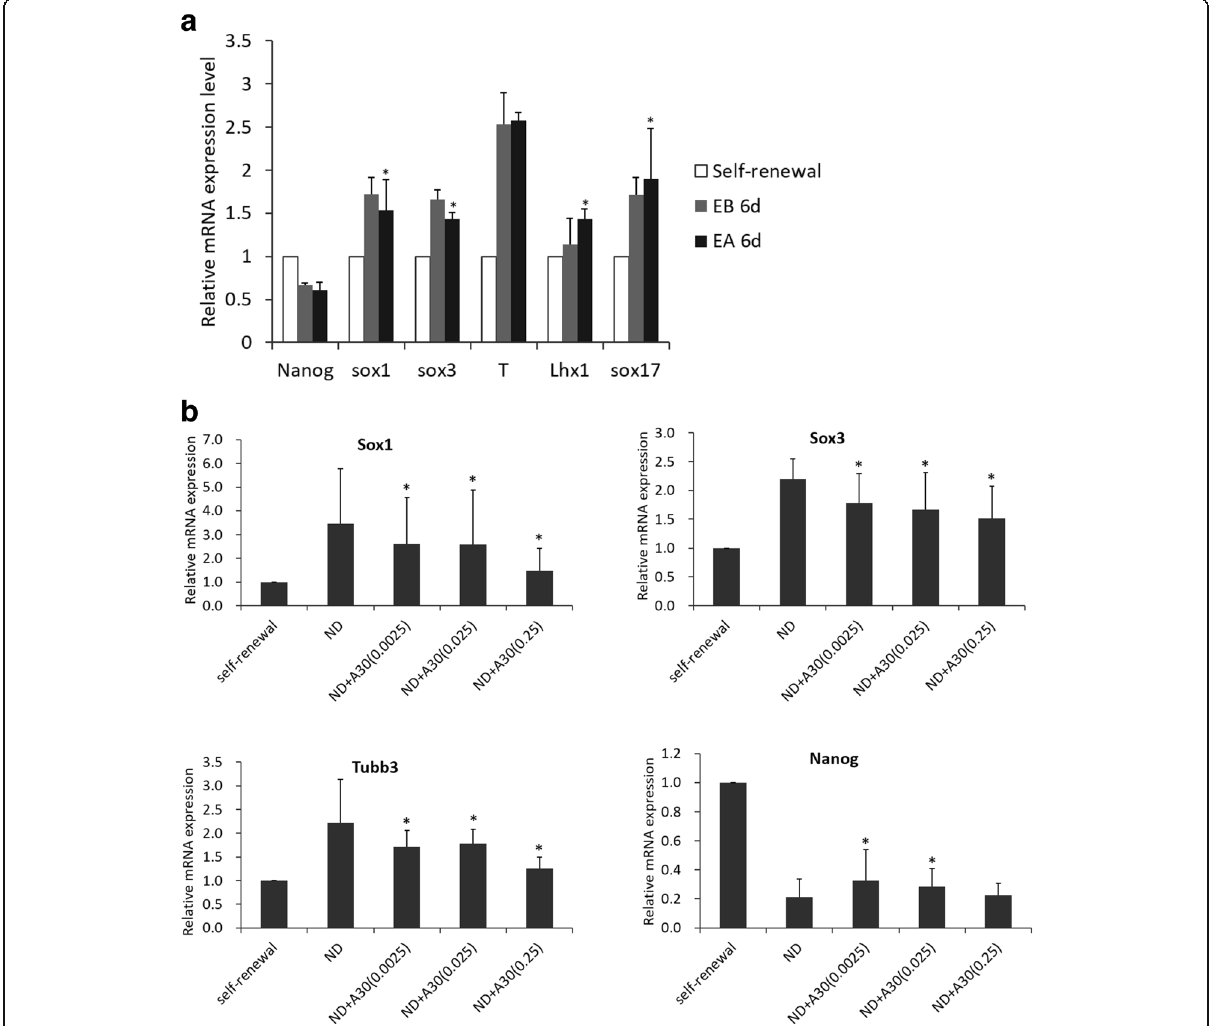
Fig. 8 Effect of A30 on differentiation of embryonic stem cells into different germ layer lineages. Nanog, stemness marker; Sox1, Sox3 and Tubb3, ectodermal differentiation markers; Lhx1, mesodermal differentiation marker; Sox17, endodermal differentiation marker; T, mesendodermal differentiation marker. a mRNA expression analysis of ectodermal, mesodermal and endodermal differentiation markers in MESC-R1 derived embryoid body (EB) upon the A30 treatment for 6 days after EB formation. Self-renewal, undifferentiated MESC-R1 cells; EB, embryoid body- differentiated MESC-R1 cells; EA, embryoid body differentiated MESC-R1 cells treated with 0.25 μ g/ml of A30. b mRNA expression analysis of ectodermal differentiation markers in neuroectodermal differentiated MESC-R1 cells upon the A30 treatment at different concentrations for 5 days. Self-renewal, undifferentiated MESC-R1; ND, neuroectodermal differentiated MESC-R1. A30 concentration umit is μ g/ml. The symbol * represents p < 0.01 compared with EB group ( a ) or ND group ( b ) by ANOVA with Tukey ’ s test post-hoc for the corresponding mRNA expression ( n =